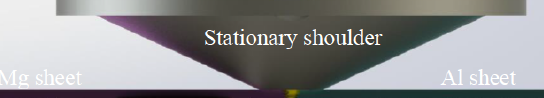
Figure 1: Schematic during SSFSW of Al/Mg